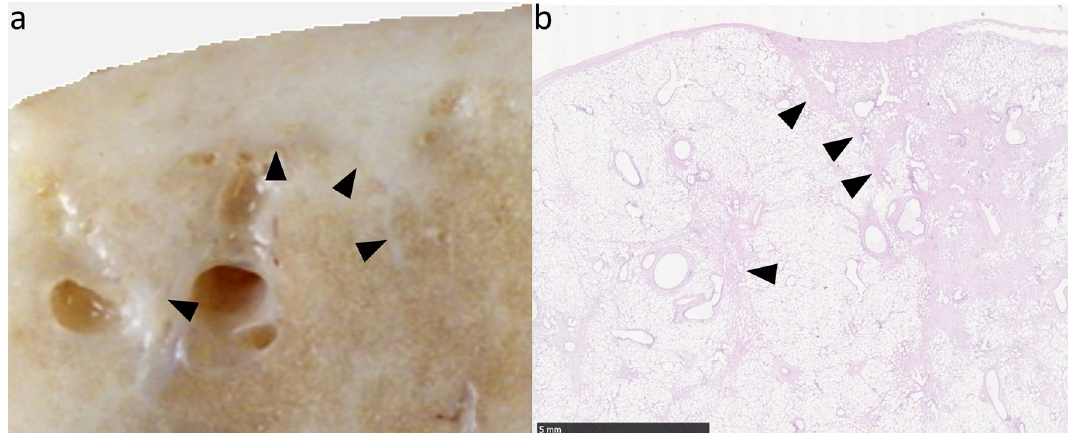
Figure 2. Gross and histological evidence of fibrotic change. ( a ) Photograph of a piece of fixed lung from ED980. The pleura, which is grossly thickened with fibrosis, lines the upper margin and fibrotic change also extends into the lung substance along septal boundaries (arrowheads). ( b ) Photomicrograph of a haematoxylin and eosin stained histological field from the same block. The nature of the grossly evident fibrosis is confirmed (arrowheads) (scale bar = 5 mm).